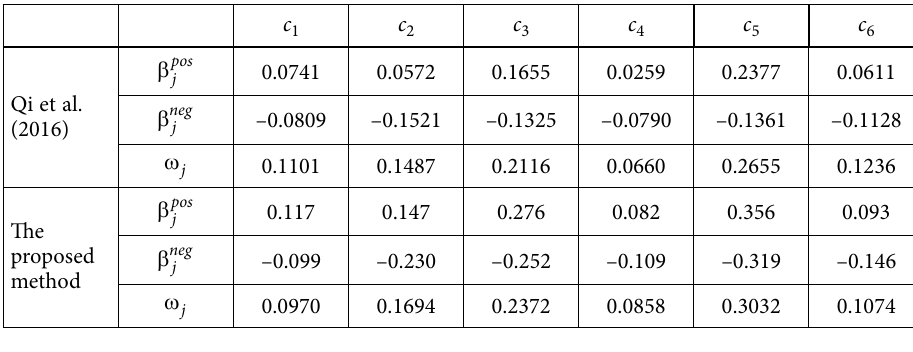
Table 13. The comparison of the attribute types in different method Attributes Attribute types in the method proposed by Qi Attribute types in the proposed method